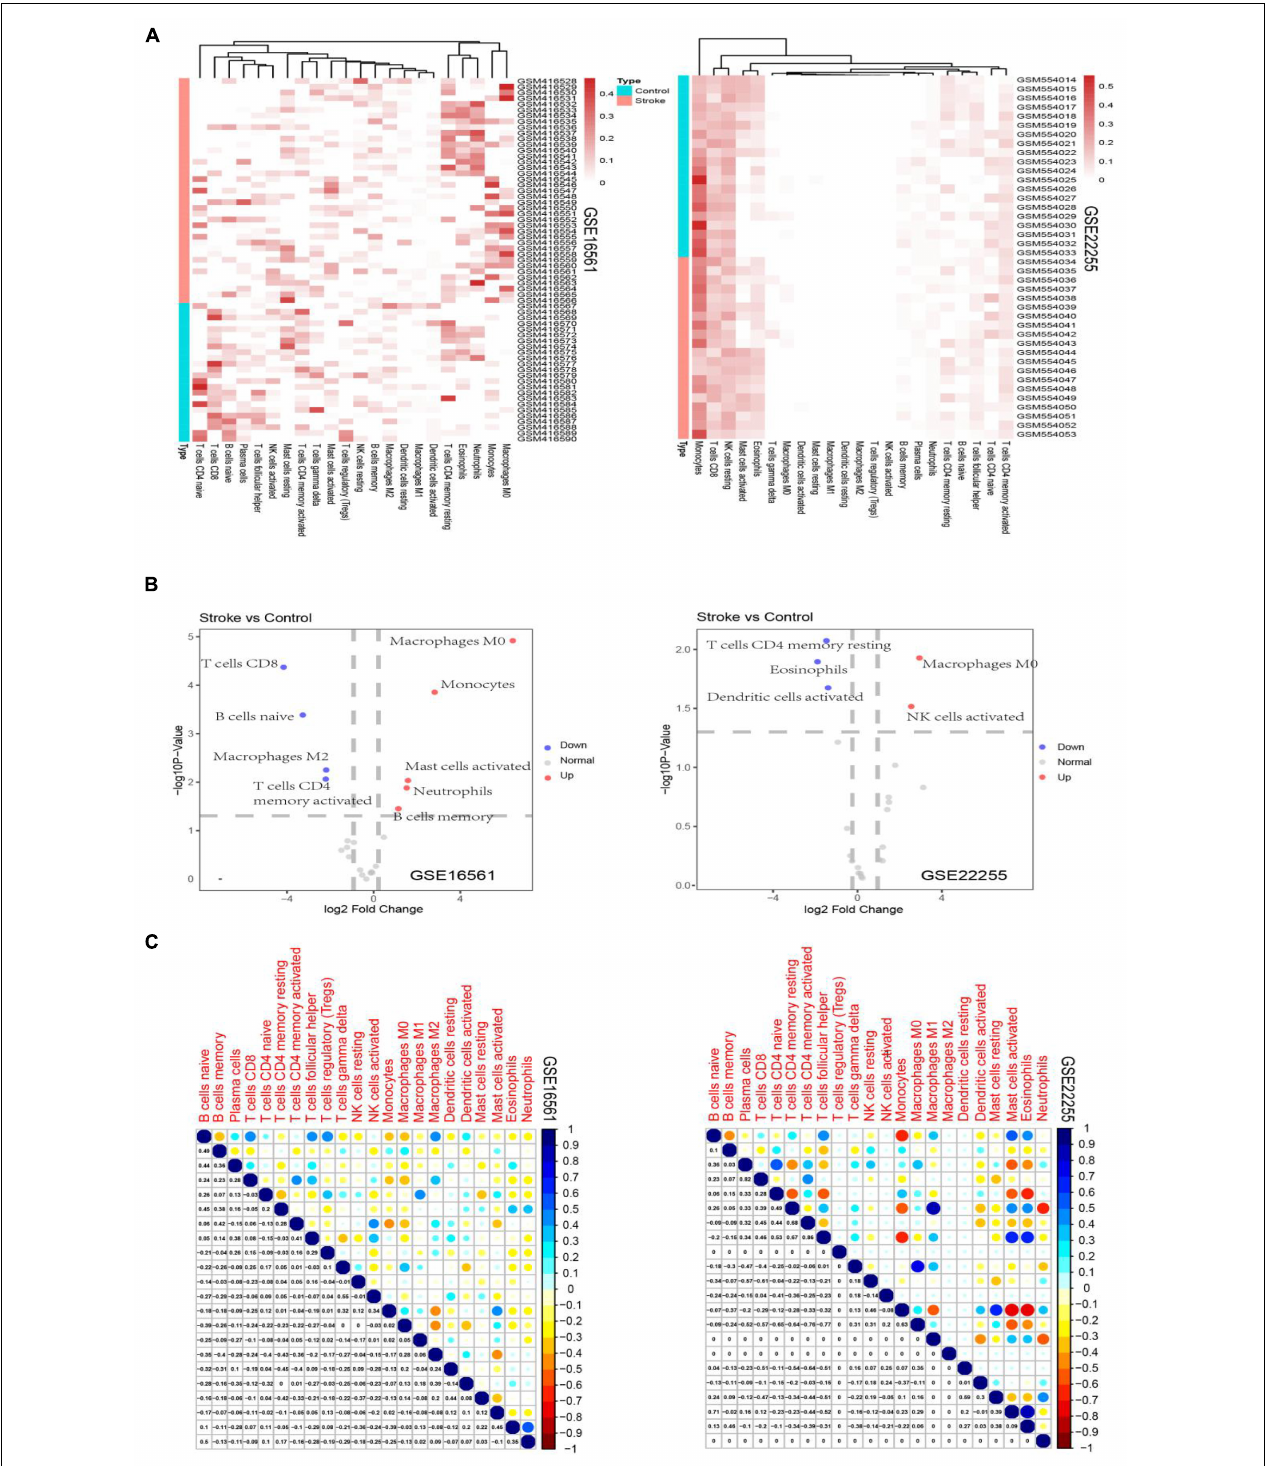
FIGURE 1 | Heatmaps depicting the proportion of immune cell subtypes in the GSE16561 and the GSE22255 datasets (A) . Volcano plots depict the log2fold change of significantly up-regulated and down-regulated cellular subsets in the GSE16561 and the GSE22255 datasets (B) . Correlogram plots depicting the correlations between immune cell subtypes (C)